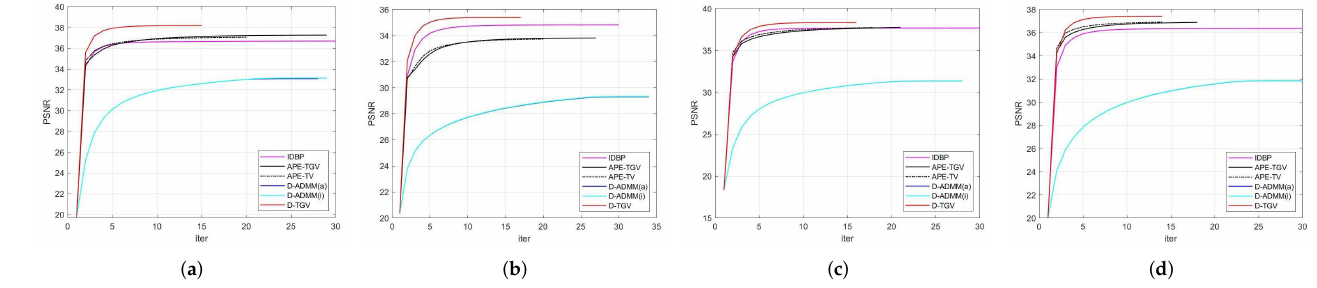
Figure 6. Iteration-varying of PSNR. ( a ) Lena, ( b ) Banoon, ( c ) cameraman, and ( d ) building. Table 1. Restoration results on PSNR, SSIM, and iterations (Bold fonts denote the best). PSNR SSIM